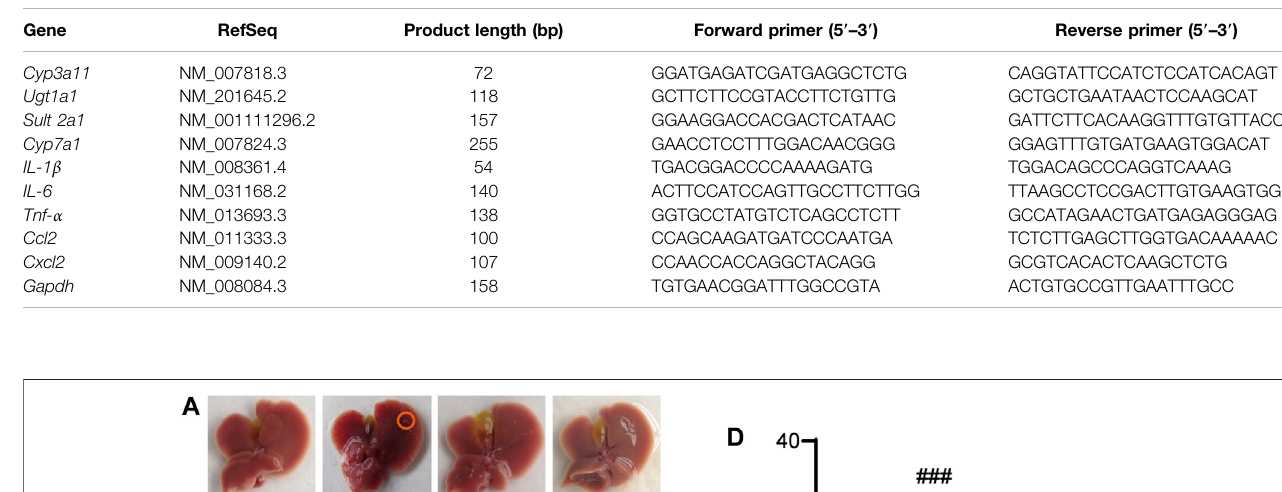
TABLE 1 | Primer sequences for RT-PCR.